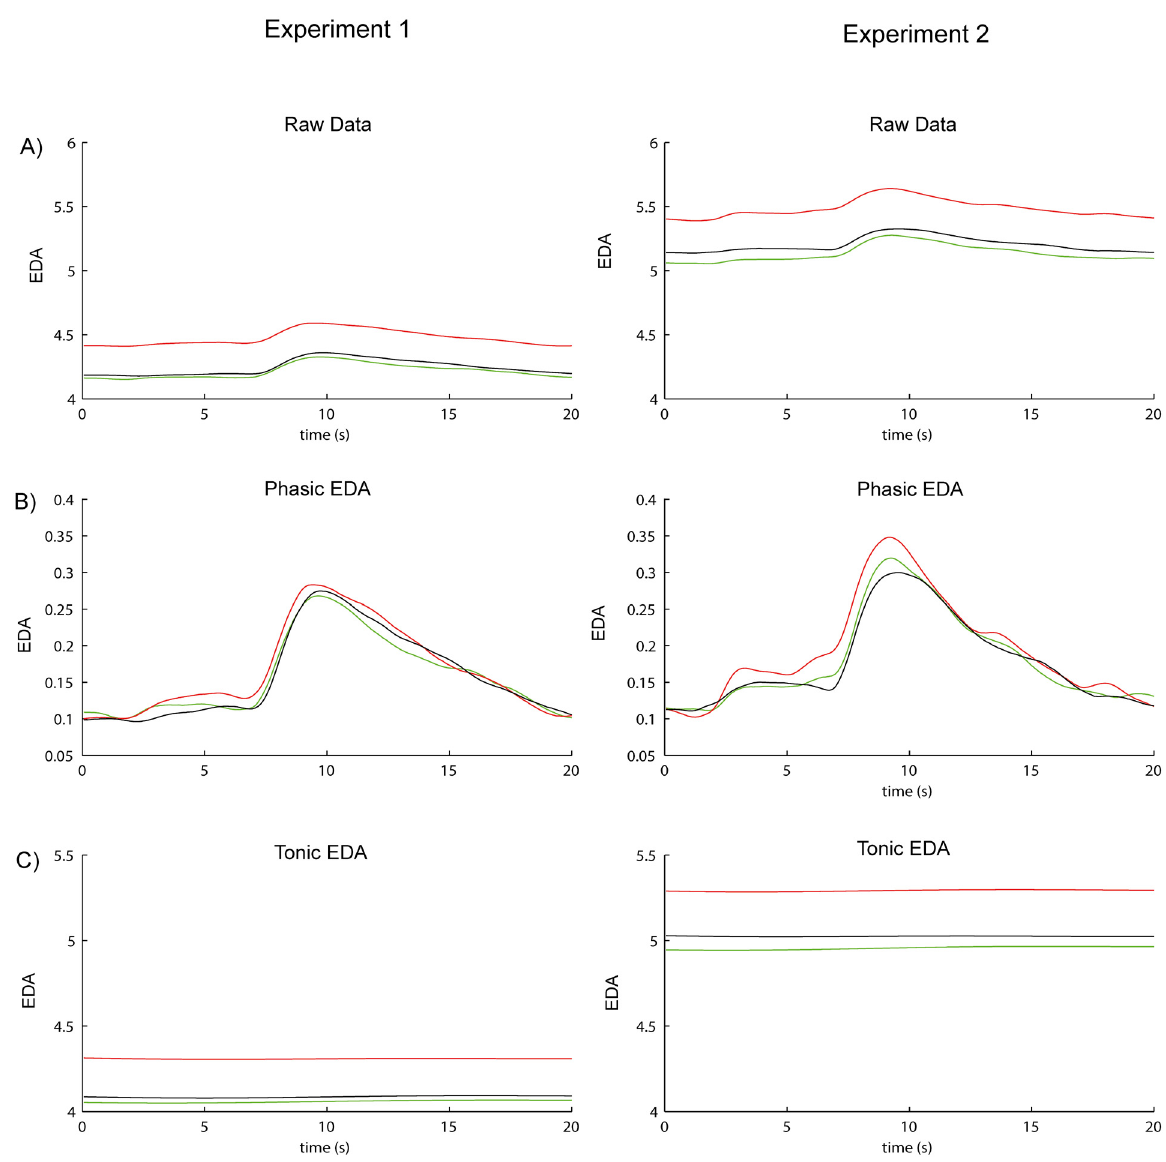
Fig 3. Mean EDA during a trial. We separated raw skin conductance data (A) into a continuous signal of phasic EDA (B) and tonic EDA (C). The graphs present the mean course of skin conductance during a trial (20 s) per condition. The left panel shows EDA for Experiment 1 and the right panel shows EDA for Experiment 2. Both show the same course pattern. For the statistical analysis we used an interval from 2 till 13 seconds (dotted lines). To separate the raw signal into its components, continuous decomposition analysis (CDA) by Benedek and Kaernbach (2010) was used. It is important to note, that phasic EDA is mapped in μ S. However, the phasic EDA was time integrated in a later stadium of the CDA analysis. This means that the unit finally changes into μ S *